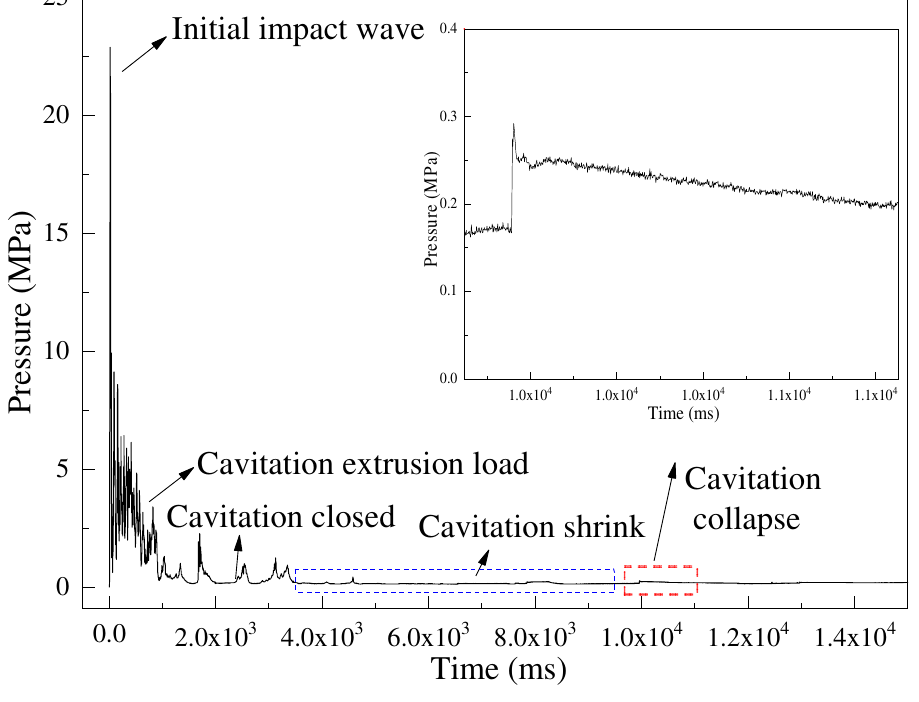
Figure 15. Load curve of measuring points in Test 3.